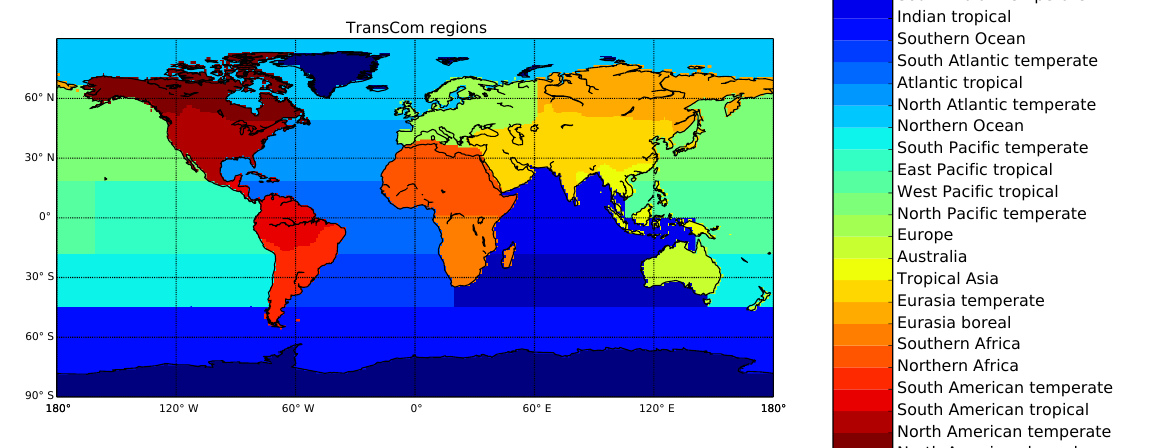
Figure 2. Earth’s partitioning into 11 land regions and 11 ocean regions according to the TransCom project. The ocean regions are divided into 30 smaller basins (not shown) and the land regions can contain up to 19 different ecoregions as shown in Fig.